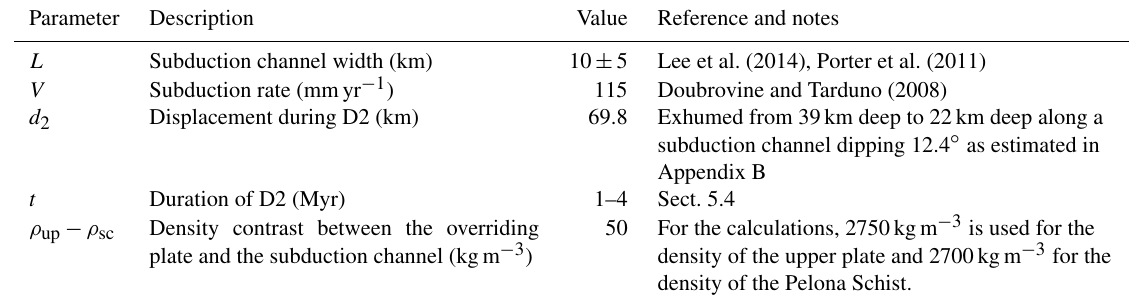
Table D1. Parameters used for subduction channel calculations.